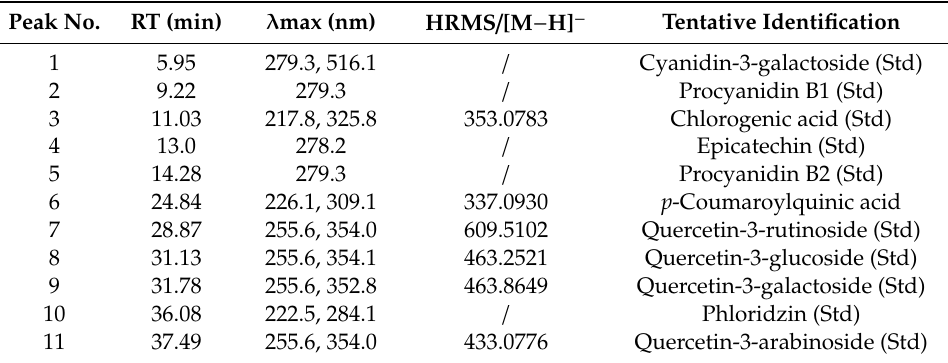
Table 4. Identification of chief phenolic compounds in apple fruit.